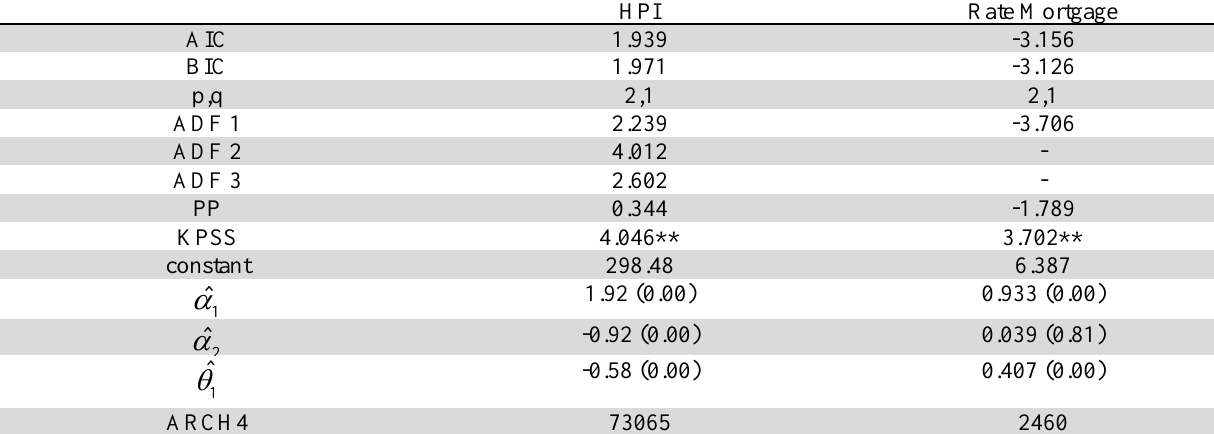
Integrated test of HPI and mortgage market rate